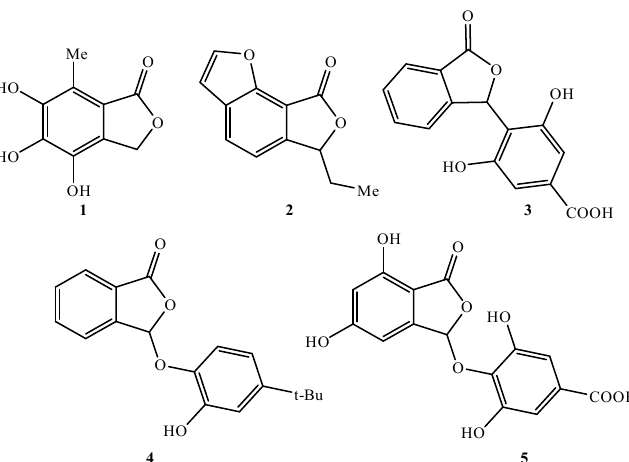
Figure 1. Some examples of phthalide derivatives with outstanding biological activities. Additionally, phthalide derivatives are important intermediates in the synthesis of other relevant heterocyclic systems, as is the case for 2,3-dihydro-1 H -isoindol-1-one deriva- tives, which are another type of unique molecules [6–9] (Scheme